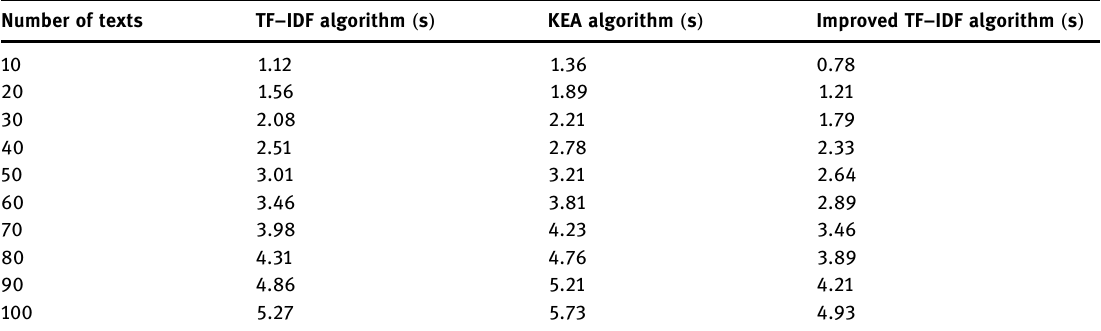
Table 4: Comparison of the running time between algorithms Number of texts